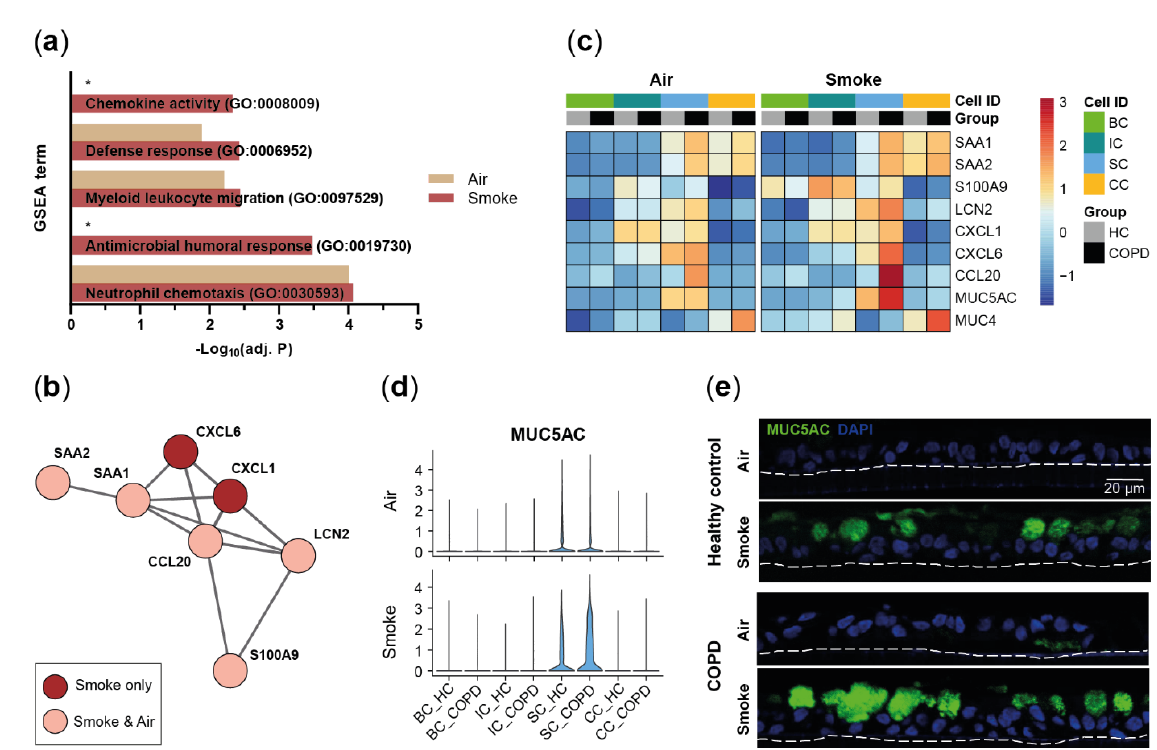
Figure 3. COPD-derived SAECs are characterized by a pro-inflammatory gene expression profile. ( a ) GSEA on the genes up-regulated in COPD compared to HC in at least one cell type. Selected significantly (adj. p < 0.05) enriched molecular processes are shown for air control and smoke-exposed cells. ( b ) Protein – protein interaction network of pro-inflammatory and anti-microbial genes that are increased in air control and/or smoke-exposed cells of COPD donors. ( c ) Relative expression of the gene set from ( b ) and de-regulated mucin encoding genes across the main SAEC populations from HC- and COPD-derived air control and smoke-exposed ALI cultures. ( d ) Violin plots illustrate MUC5AC expression across the main cell types in air control and smoke-exposed SAECs from COPD and HC donors. ( e ) Representative immunofluorescence labelling of MUC5AC in air control and smoke-exposed SAEC sections from HC and COPD donors. *: pathway not significantly enriched (adj. p > 0.05).